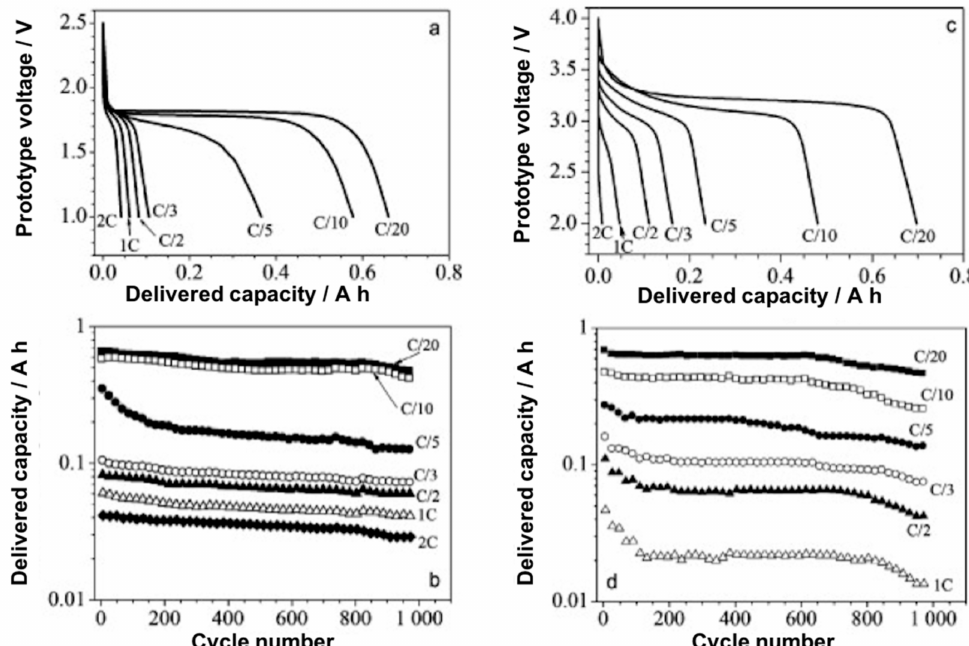
Figure 11. ( a , c ) First discharge voltage profiles and ( b , d ) capacity vs. cycle number at indicated discharge current rates of ( a , b ) LFP | 0.9:0.1 C 4 mpyrFSI:LiTFSI | LTO at 20 ◦ C (Li-ion battery) and ( c , d ) LFP | cl-PEO-C 4 mpyrTFSI-LiTFSI | Li at 40 ◦ C (Li metal polymer battery). Reprinted with permission from Balducci et al.